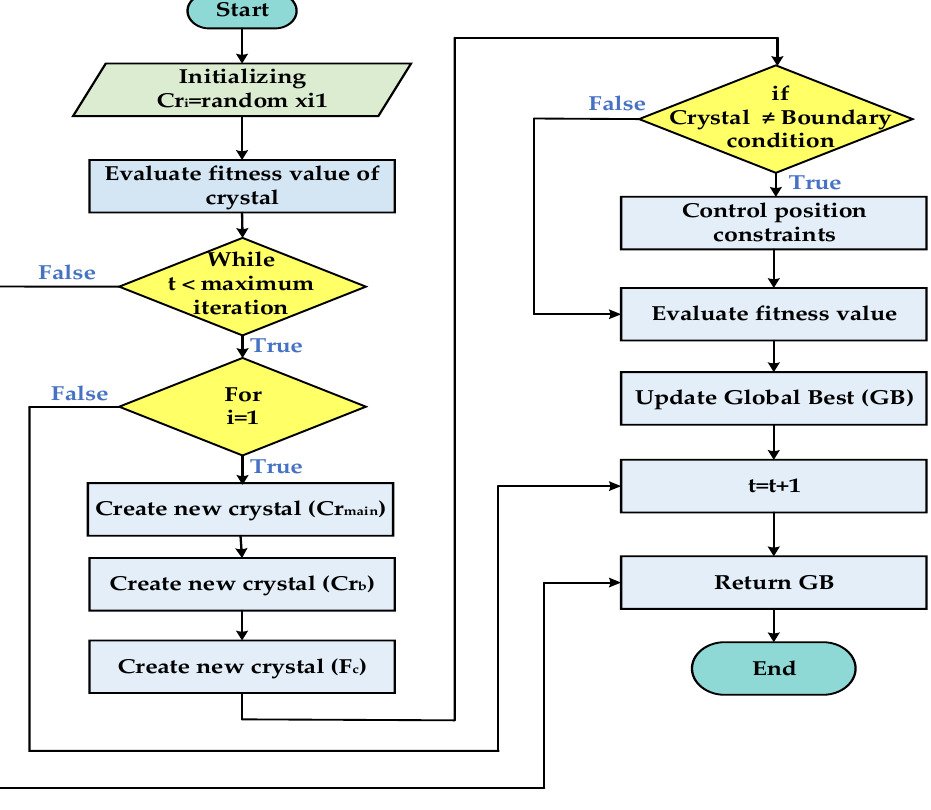
Figure 6. Flow chart of Crystal Structure Algorithm (CryStAl).